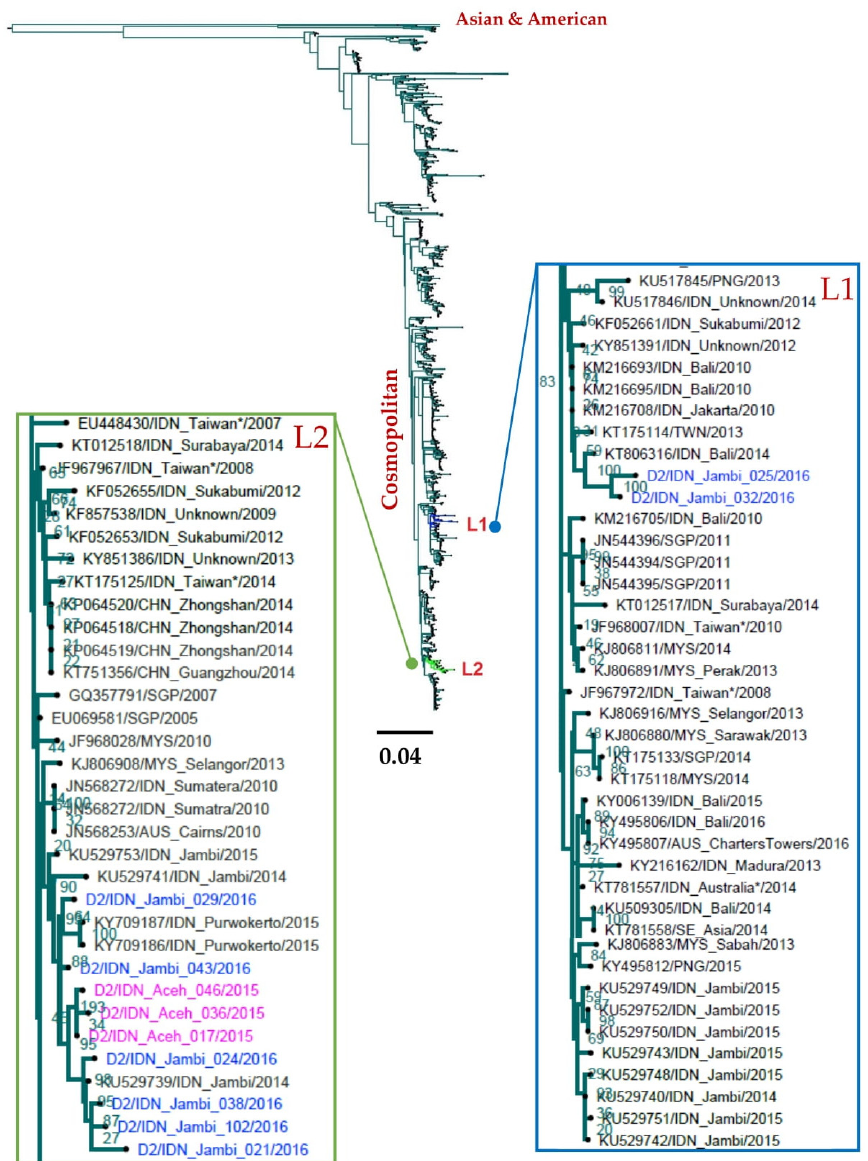
Figure 3. Phylogenetic tree of DENV-2 isolated from Aceh and Jambi showing two lineages (L1 and 2). The tree was generated using the maximum likelihood method using RAxML with a GTR+ Γ model of an alignment including three viruses from Aceh, eight viruses from Jambi, and 3469 sequences from NCBI. Some phylogenetic clusters have been collapsed to reveal the positions of isolated viruses in more detail. All identified viruses belong to the Cosmopolitan genotype and clustered into two lineages (L1 and L2). Blue indicates viruses from Jambi and pink indicates viruses isolated from Aceh. Green box indicates the lineage that consists of viruses isolated both from Aceh and Jambi. L: lineage. AUS: Australia, CHN: China, IDN: Indonesia, PNG: Papua New Guinea, MYS: Malaysia, SGP: Singapore, THA: Thailand. Asterix (*) indicates virus isolated from travelers returning from Indonesia.